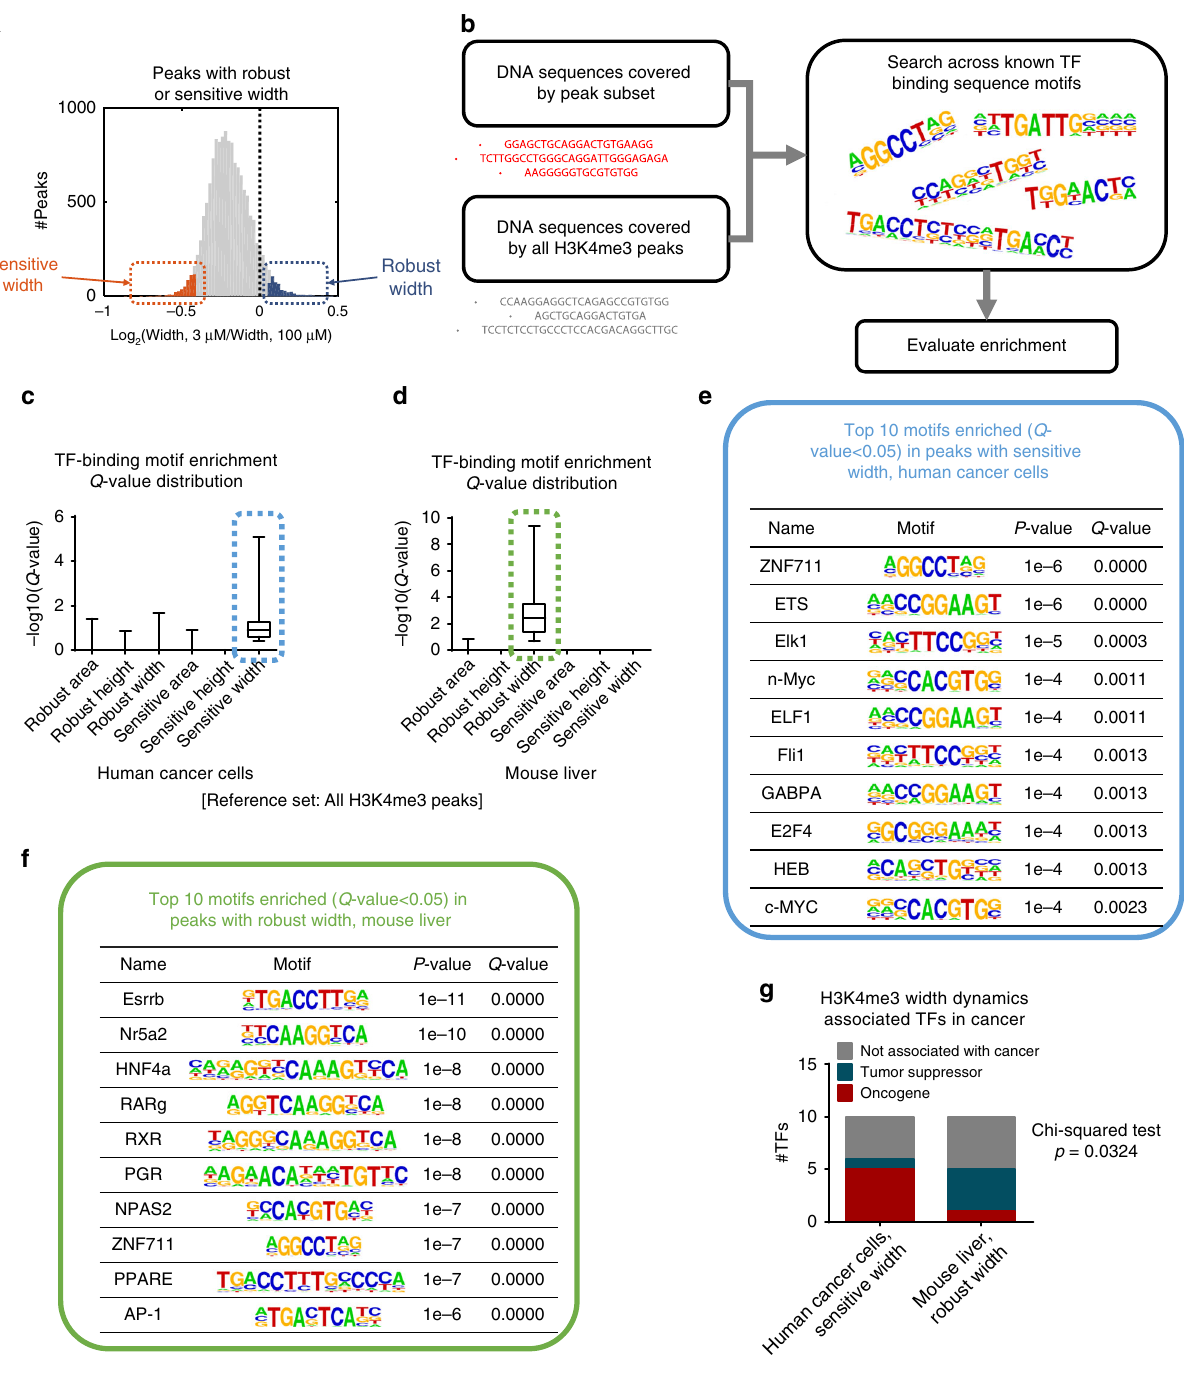
Fig. 3 H3K4me3 width dynamics encode cell type-speci fi c TF binding. a Distribution of fold changes (de fi ned by the values in low methionine condition divided by the corresponding values in high methionine condition) in peak width in all peaks (gray), top 500 peaks with sensitive width (orange) and top 500 peaks with robust width (blue) in human cancer cells. b Framework for the TF binding motif enrichment analysis. c Distributions of TF binding motif enrichment Q -values in H3K4me3 peak sets with different dynamics under MR in human cancer cells. Box limits are the 25th and 75th percentiles, center lines are medians, and the whiskers are the minimal and maximal values. d Same as in c but for mouse liver. e Top 10 TF binding motifs enriched in 500 H3K4me3 peaks with sensitive width in human cancer cells. f Same as in e but for robust width in mouse liver. g Number of oncogenes and tumor suppressors in top 10 TFs enriched in H3K4me3 peaks with sensitive width in human cancer cells and those with robust width in mouse